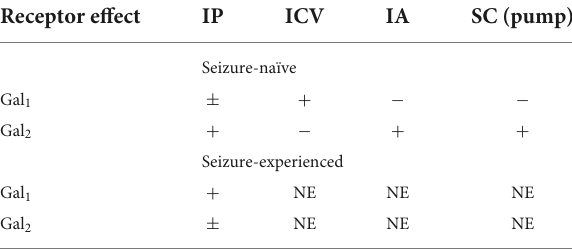
TABLE 4 Summary of major findings for the effect of galanin analogs on